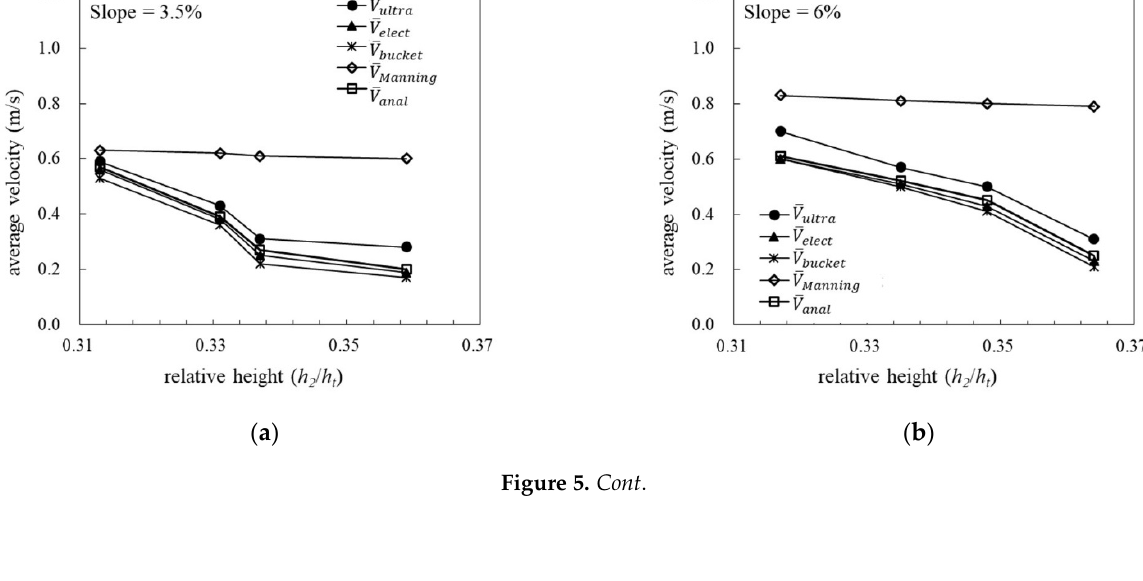
Figure 4. Average flow velocities at different relative heights for Bermuda grass with bed slopes of ( a ) 3.5%, ( b ) 6%, and ( c ) 7%.